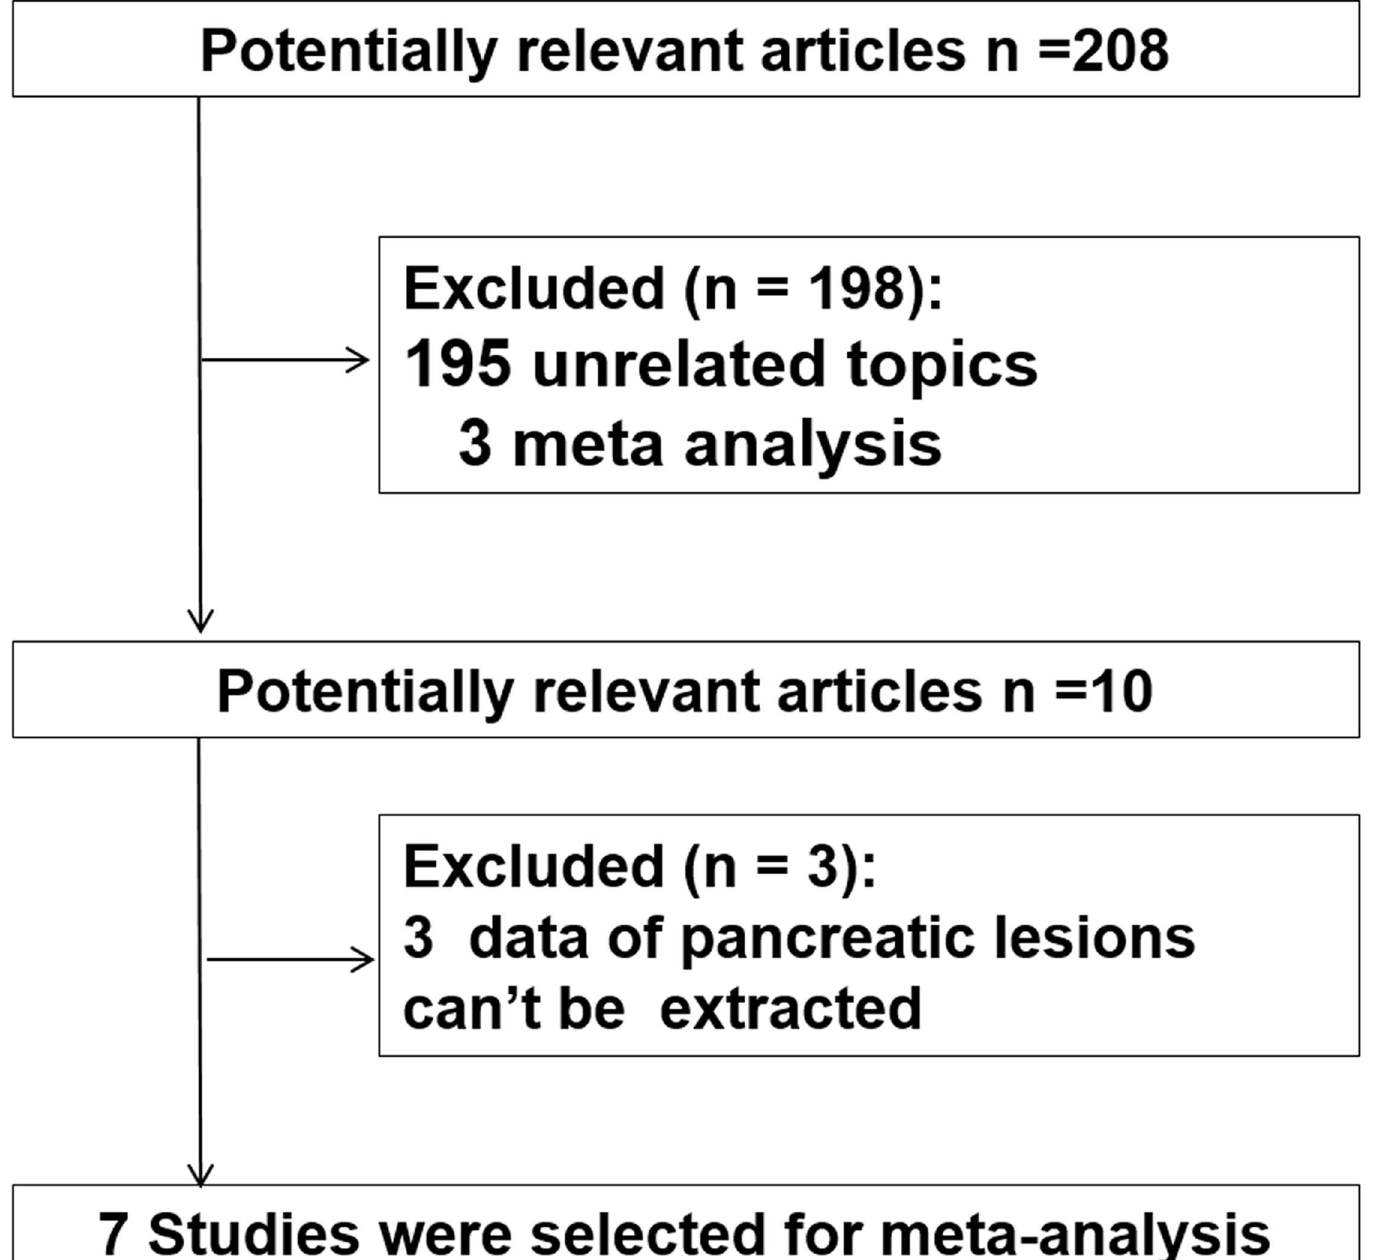
Fig 1. Flow chart of literature search and